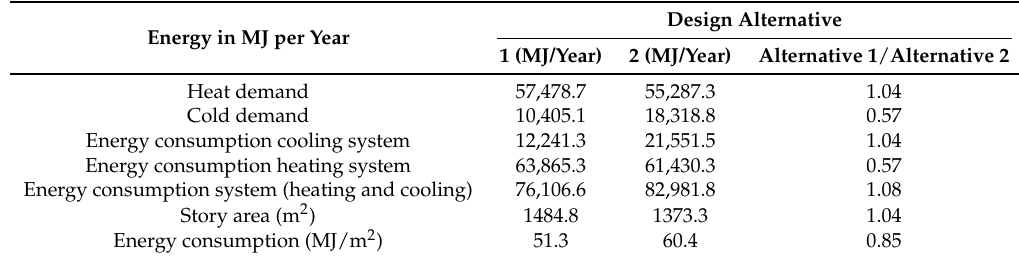
Table 6. Energy calculations for both alternatives created by